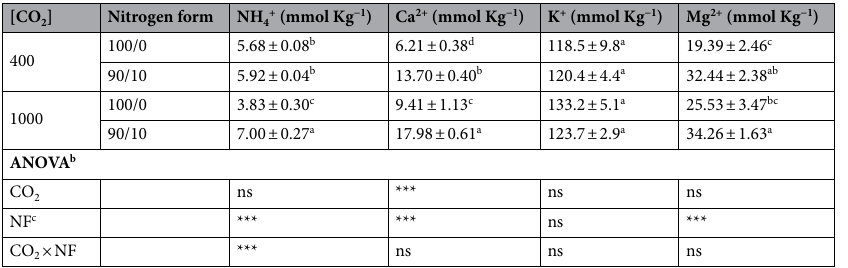
Table 1. Effect of N forms (100% NO 3− and 90% NO 3− /10% NH 4+ combined) under an elevated CO 2 concentration on the cation composition of leaves of cucumber. a Different letters within a column indicate significant (P ≤ 0.05) differences between treatments. b Analysis of variance: ns, not significant. c Nitrogen form.